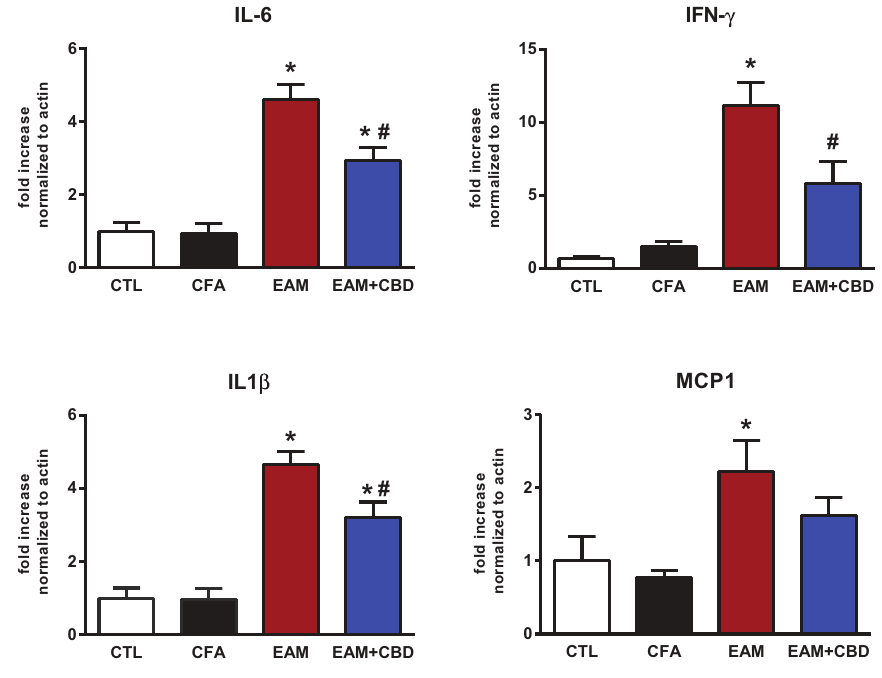
Figure 3. Effects of CBD on inflammatory cytokines in EAM. LV mRNA gene expression of proinflammatory cytokines (IL-6, IFN- γ , IL1 β ) and chemokines (MCP1) in experimental au- toimmune myocarditis. * P < 0.05 versus CTL; # P < 0.05 versus